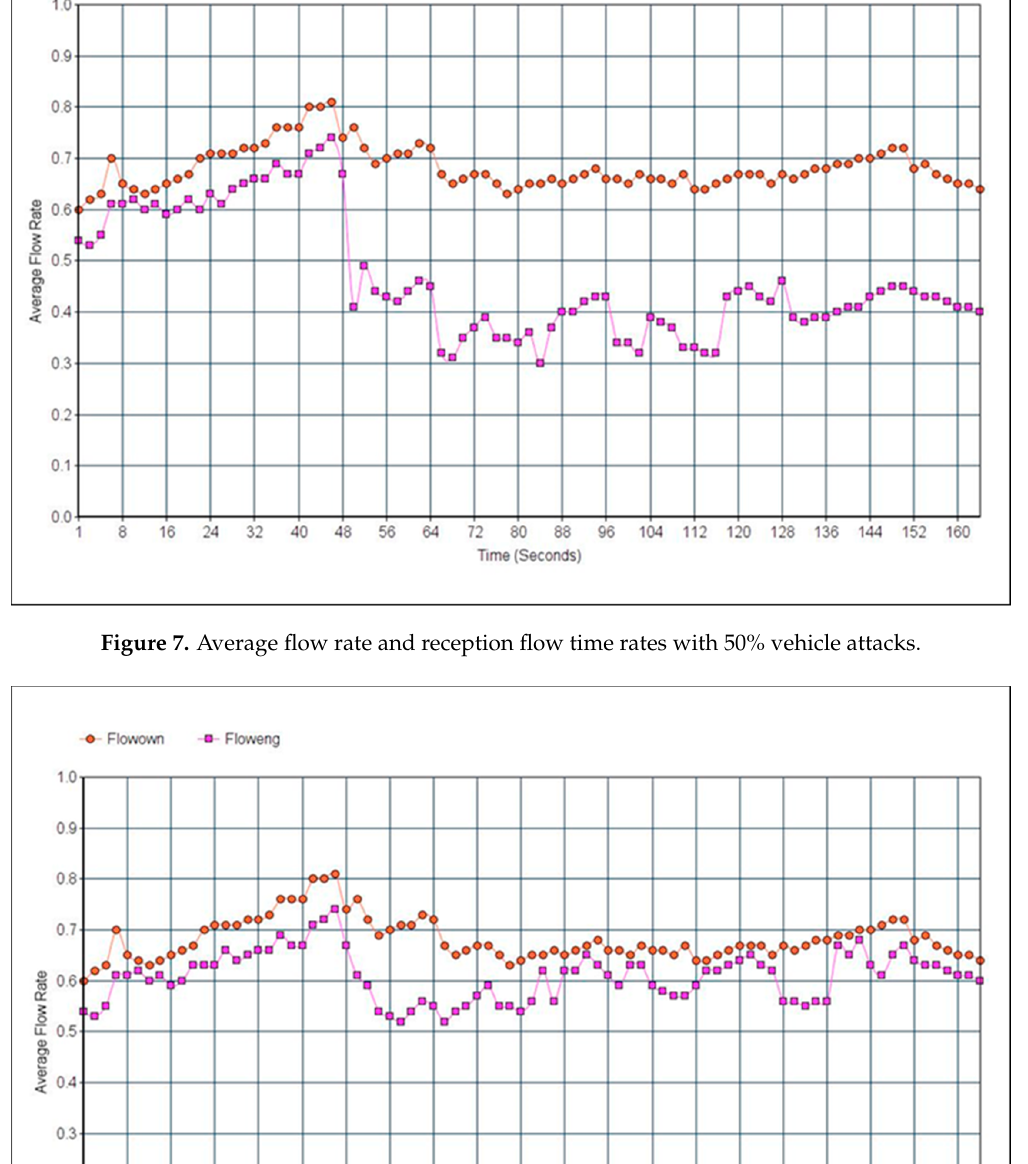
Figure 6. Average flow ( Flowown ) and reception flow ( Floweng ) rates in normal conditions.